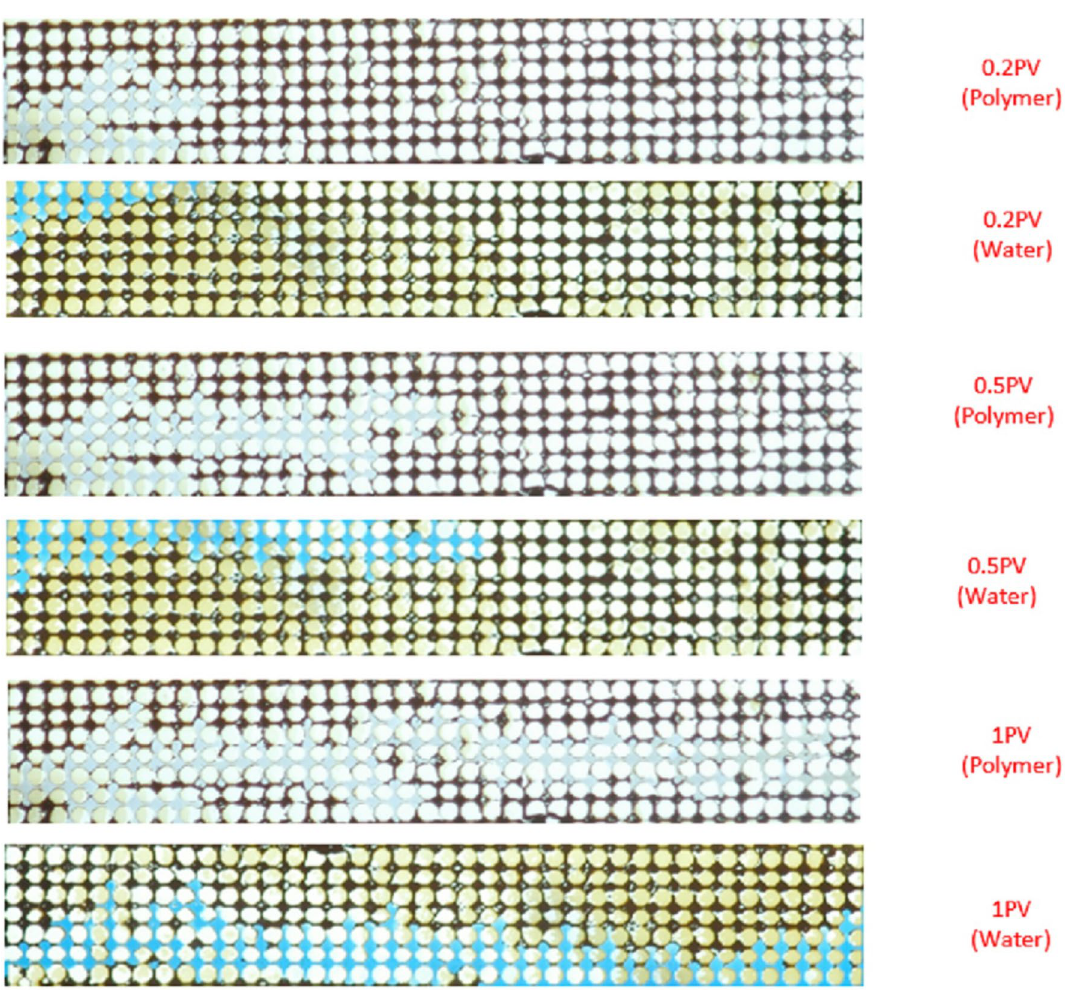
Fig. 8 Flooded patterns at equal pore volumes injected for water flooding and polymer flooding, Polymer type 1, injection rate = 0.0002 cc/min, concentration = 1500 ppm (brown color: oil, whitish blue color: polymer and blue color: water)